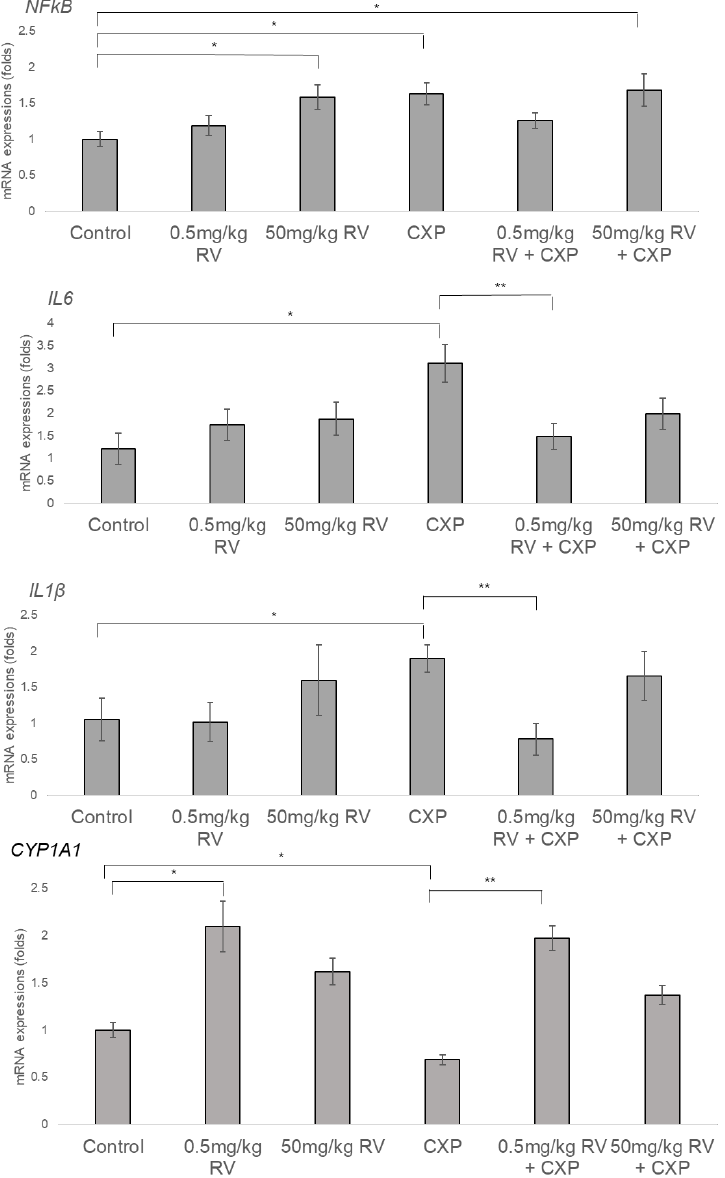
Figure 3. Compared to the CXP group, the 0.5 mg/kg RV + CXP group showed decreased mRNA levels of NF κ B, IL1 β , and IL6 . The 50 mg/kg RV + CXP group did not show any significant difference in mRNA levels of NF κ B, IL1 β , and IL6 compared to the CXP group. The mRNA level of CYP1A1 was increased in the 0.5 mg/kg RV group and 0.5 mg/kg RV + CXP group. (* p < 0.05, compared to control group, ** p < 0.05, compared to CXP